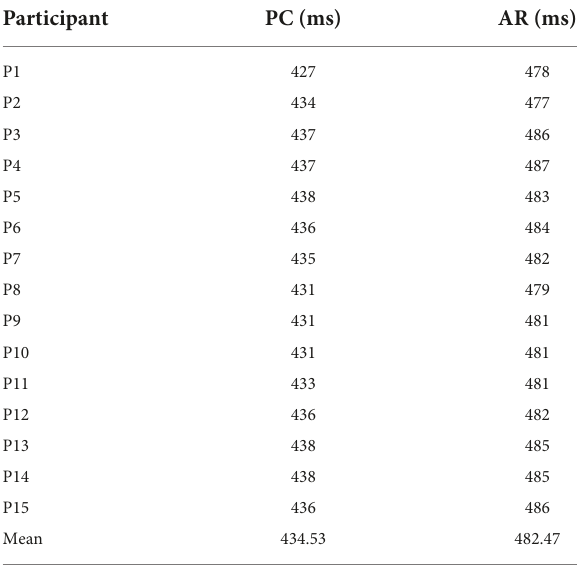
TABLE 5 Average latency of P300 for all